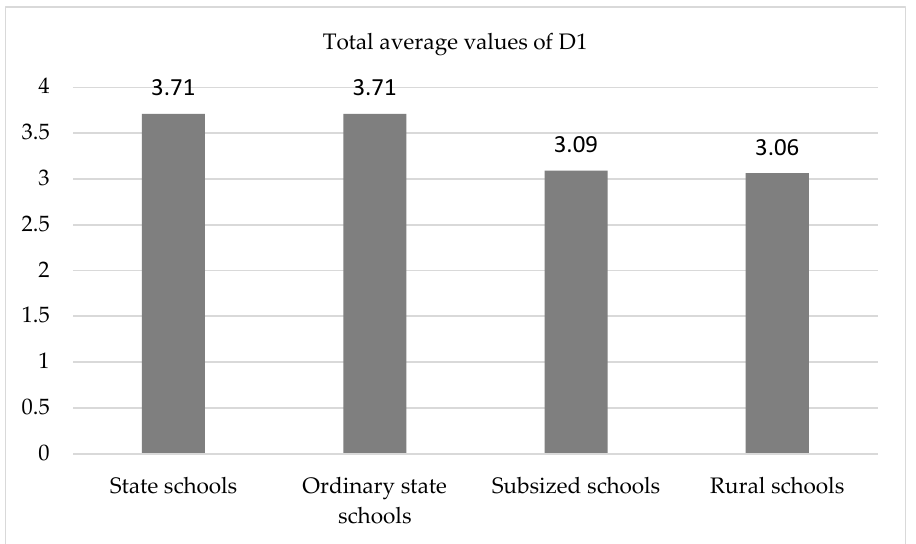
Figure 1. Diagram of the means. Overall mean values of D1 as a function of the type of school ( p < 0.05).